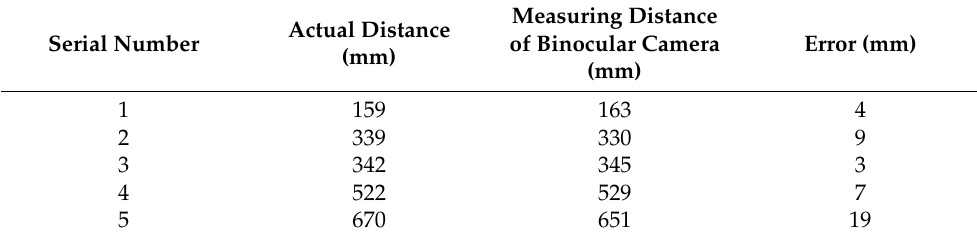
Table 5. Static distance measurement experiment data of binocular